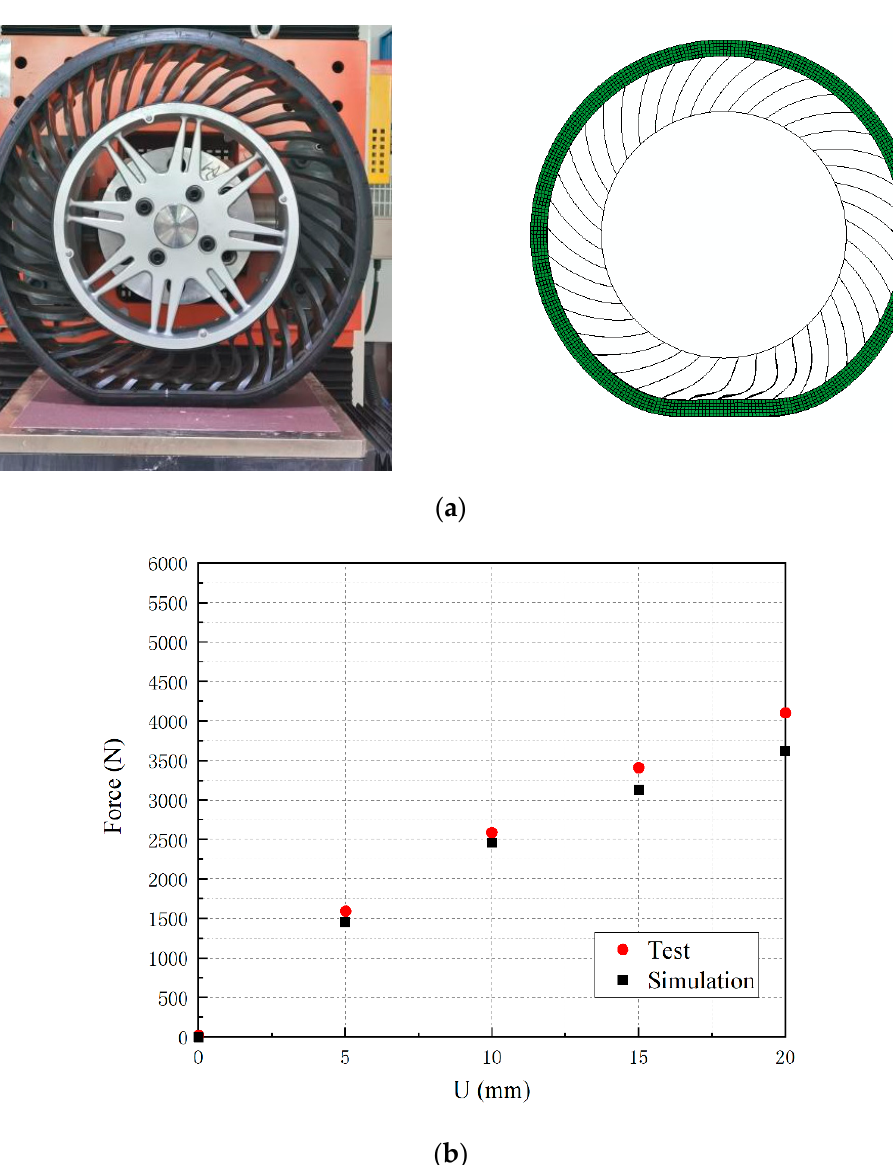
Figure 16. The experimental and simulation results of the radius-direction-optimized NPT: ( a ) the deformation of the test and simulation for the radius-direction-optimized NPT; ( b ) force-displacement of the test and simulation for radius-direction-optimized NPT.